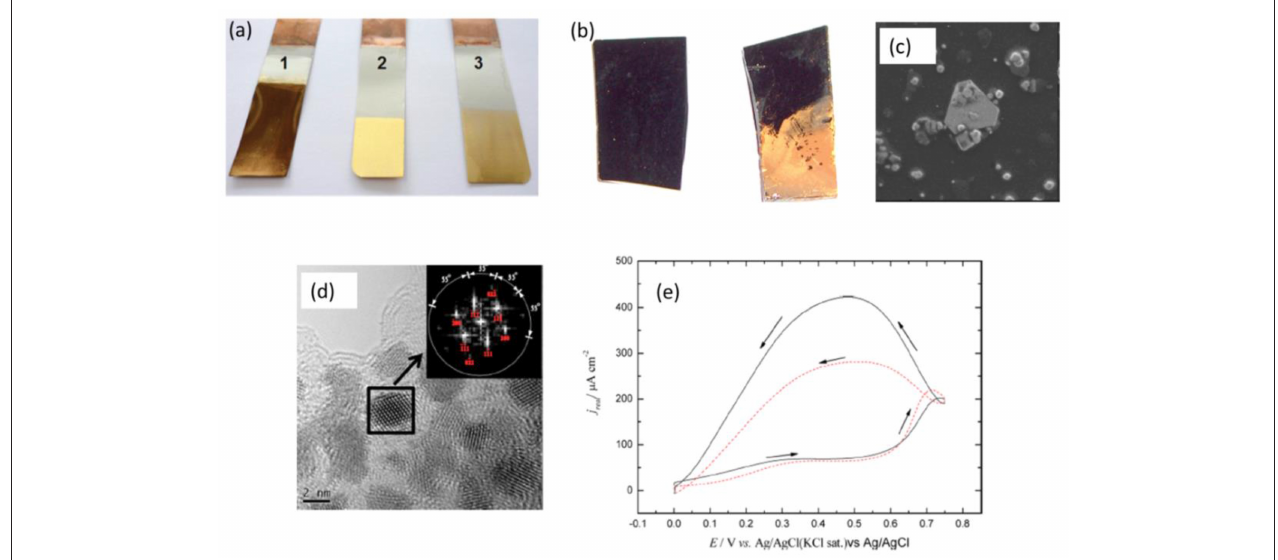
FIGURE 3 | (a) Electroless deposition of Au on nickel from (a1) AuCl (a2) AuCN (a3) KAu(CN) 2 in ChCl-1, 2-ethanediol (b) Electroless deposition of Au from H[AuCl 4 ] in EMImTFSA in presence of HTFSA on glassy carbon (c) Gold nanoplates formed by electroless deposition on glassy carbon from H[AuCl 4 ] in EMImTFSA in presence of HTFSA (d) Electroless deposition of Pt nanoparticles (e) Methanol electrooxidation on Pt nanoparticles formed by electroless deposition. Reproduced from Aldous et al. (2007), Zhang et al. (2013) and Ballantyne et al. (2015) with permission from The Royal Society of Chemistry and American Chemical Society, Copyright 2007, 2013 American Chemical